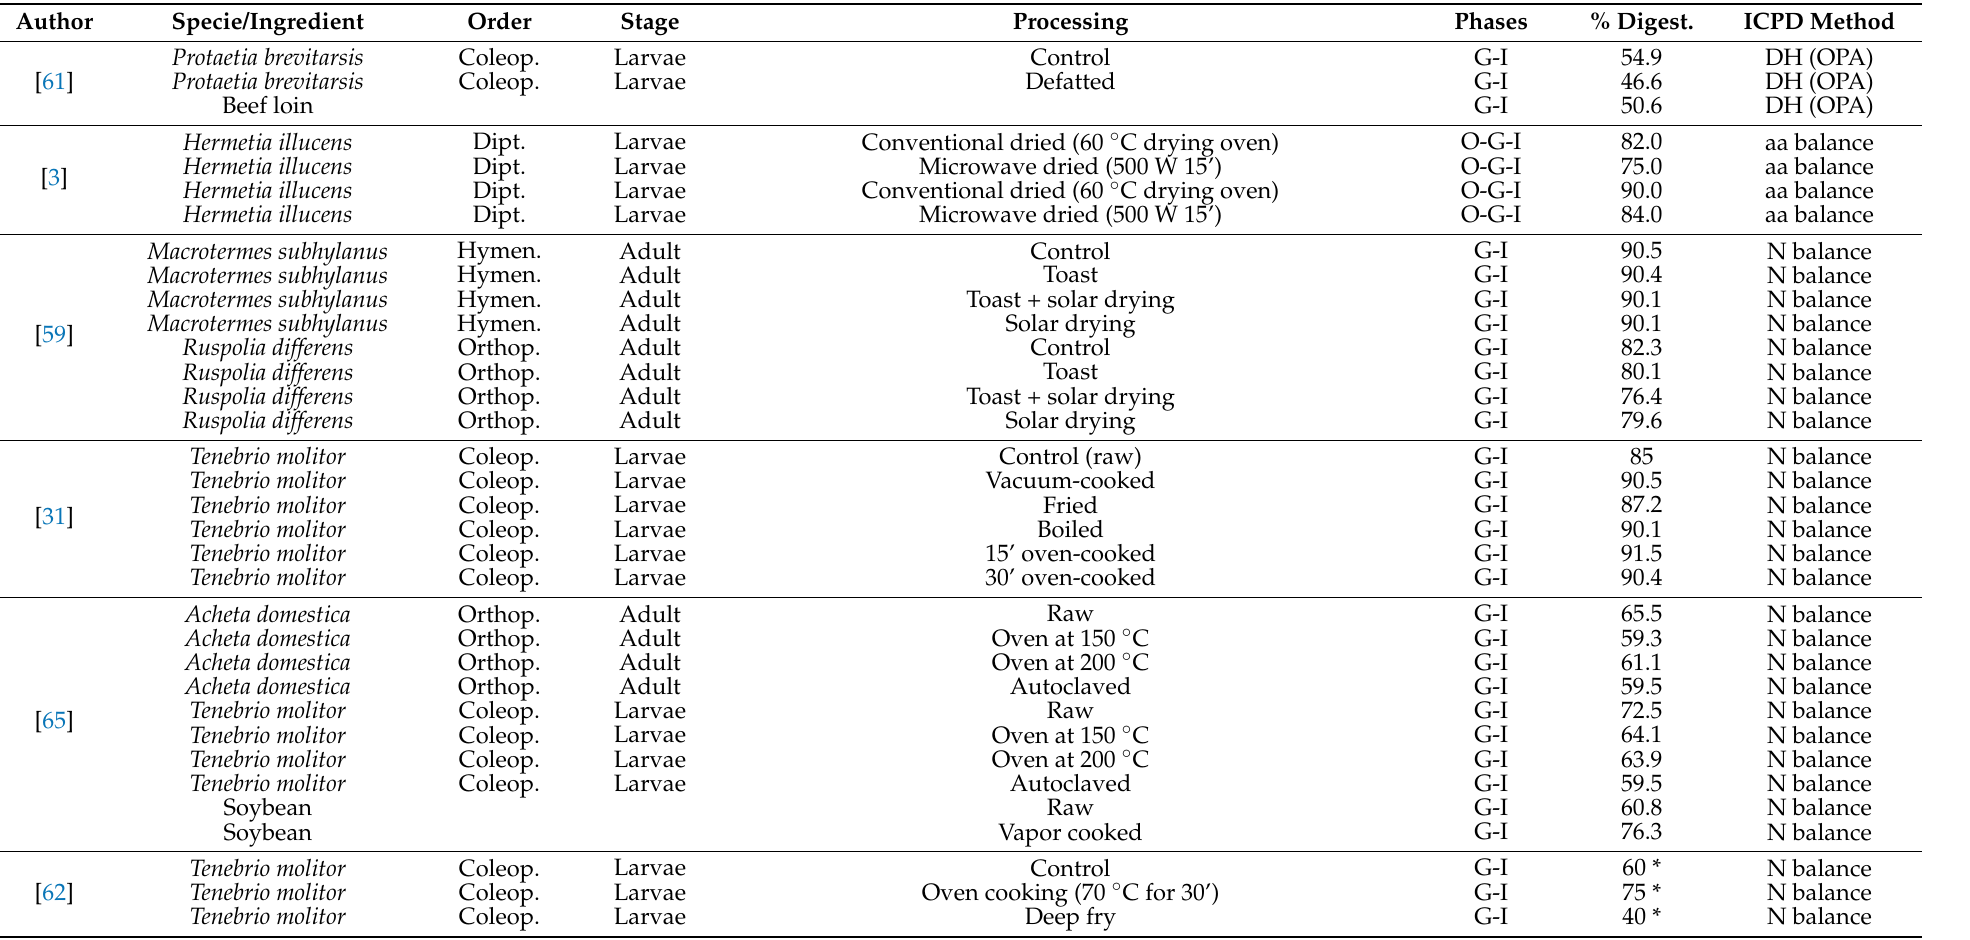
Table 4. Effect of different processing methods on insect